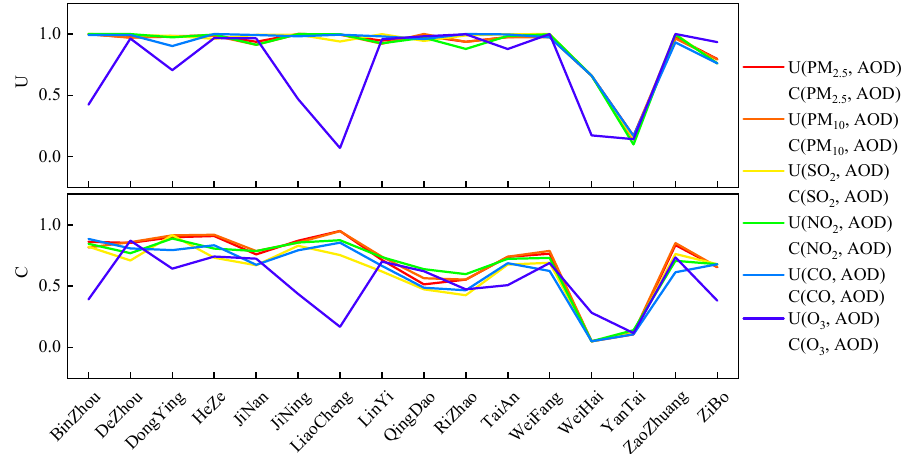
Figure 7. Coupling degree and coupling coordination degree of AOD and each pollution indicator. Figure 8 shows that, except for O 3 , the coupling coordination degree between each pollutant indicator and AOD has the characteristics of being high in the west and low in the east. In terms of the level of coupling and coordination between pollutant indicators and AOD, PM 2.5 and PM 10 are the highest. In terms of the gaseous pollutant indicators, the coupling coordination degree between NO 2 and AOD is higher. To reflect the changes in the distribution of coupling coordination degree, the distributions of 2015, 2019, and 2020 were also selected for comparison. It is found that except for O 3 , the coupling coordination degrees all show an increase and then a decrease from 2015 to 2020. The areas of change are mainly concentrated in the central region, which is mainly reflected in two types of solid particulate matter, PM 2.5 and PM 10 . The coupling coordination degrees between the other three gaseous pollutants and AOD are similar in terms of spatial and temporal var- iations, except for the large fluctuations of the coupling coordination degrees between O 3 and AOD.